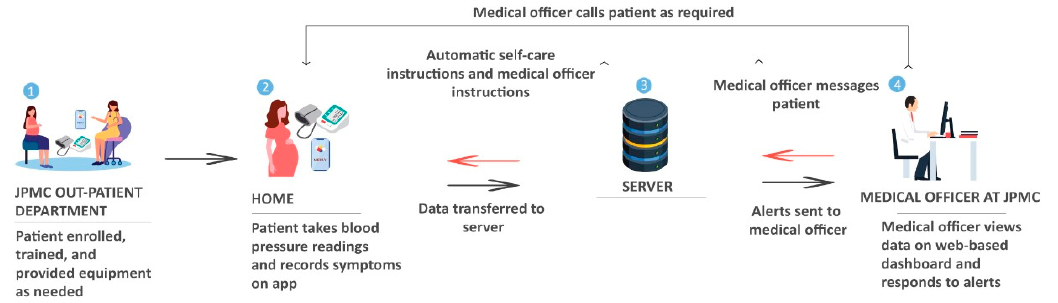
Figure 1. Proposed patient and clinician workflow for the telemonitoring program at JPMC.